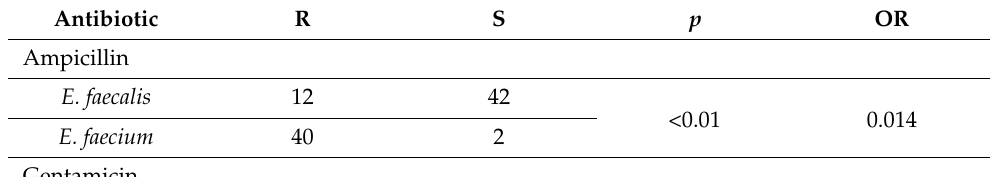
Table 9. Statistical analysis of antibiotic resistant strains in E. faecalis and E. faecium associations are presented in Table 9.